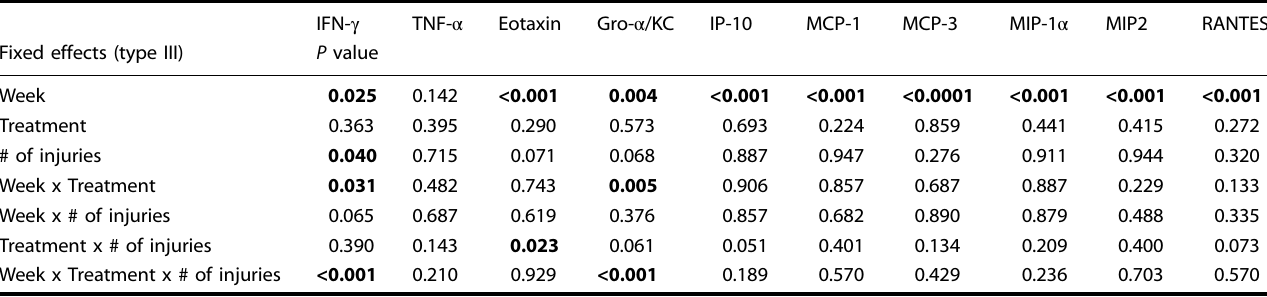
Table 2. Mixed models analysis of systemic chemokines and